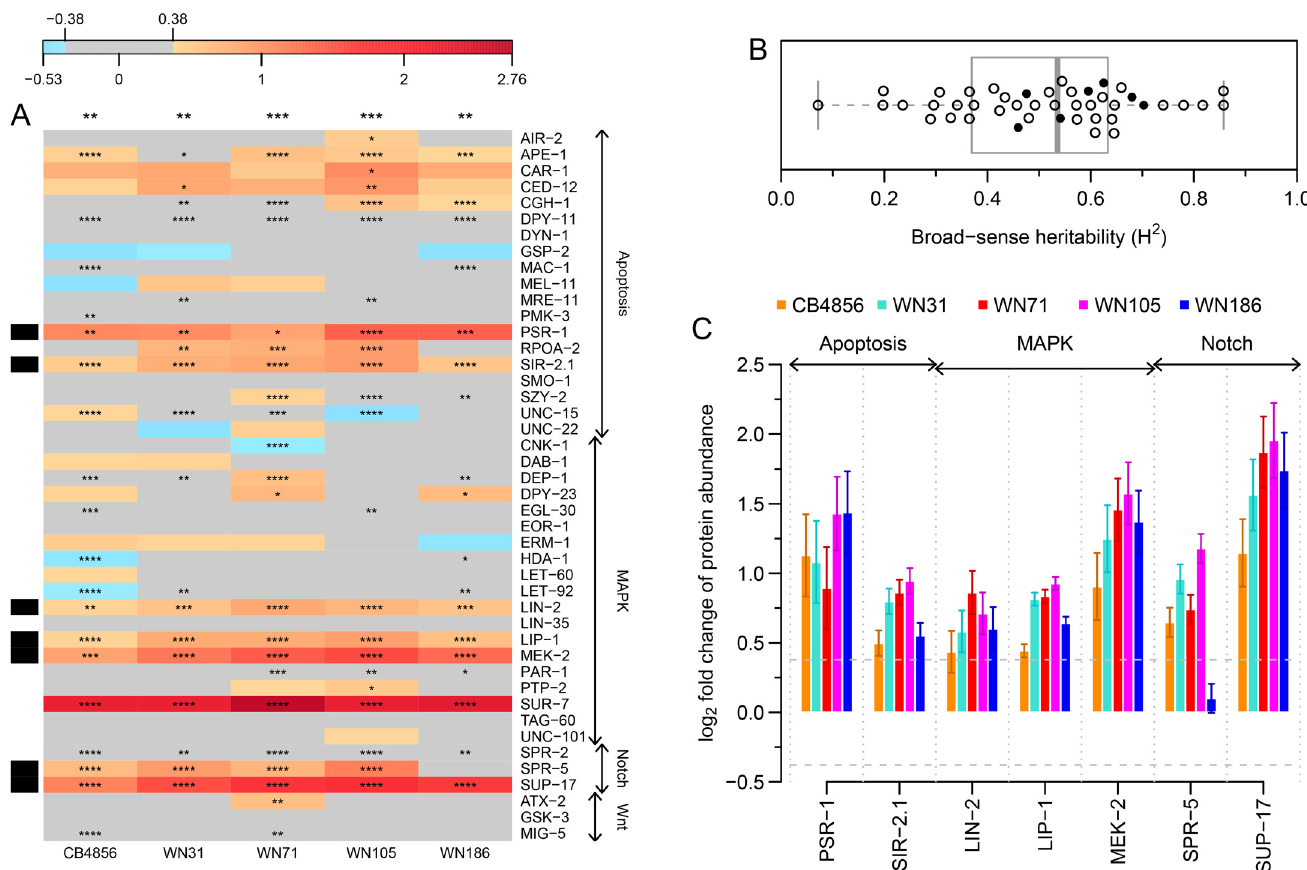
Fig 3. Signalling pathway proteins tend to be up-regulated in CB4856 and in RILs compared to N2. Protein abundance was quantified by SRM. Identification of the true peak group was performed using the mProphet software, followed by protein significance analysis using intensity-based linear mixed-effects model implemented in MSstats. (A) Heat map showing differential abundance of 44 proteins in CB4856 and four empirically selected RILs relative to N2. Blue and red shades represent log 2 scaled fold changes, grey colour shows the fold change cut-off of 1.3 (~ 0.38 on log 2 scale) and number of asterisks represent BH corrected P -values. Black bands on the left side indicate proteins selected for subsequent pQTL mapping. Number of asterisks on top of each column represent BH corrected P -values from one sample t-test (H 0 : μ = 0 and H 1 : μ 6¼ 0) on protein fold changes relative to N2; * P (cid:1) 0.05; ** P (cid:1) 0.01; *** P (cid:1) 0.001; **** P (cid:1) 0.0001. (B) Tukey-style box plot of broad-sense heritability for the 44 proteins shown in panel A. Scatter points overlaid on the box plot represent the broad-sense heritability values for the individual proteins (solid black circles correspond to selected proteins). (C) Bar graph of selected proteins from panel A. Horizontal dashed lines represent the fold change cut-off of 1.3 (~ 0.38 on log 2 scale). Error bars represent SEM between three biological replicates.